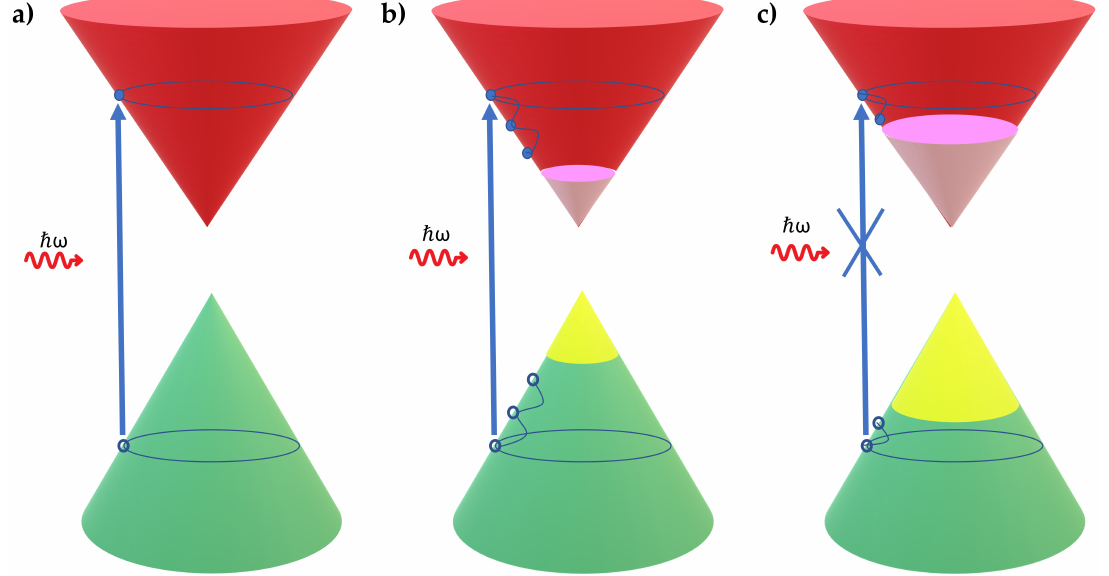
Figure 4. Absorption of photons in silicane: ( a ) schematic excitation process, where the arrow corresponds to an interband transition; ( b ) the photoexcited carriers thermalize and cool down to form a Fermi-Dirac distribution; ( c ) under high incident laser intensity, the photoexcited carriers occupy all the available states near the edge of the conduction and valence bands, thereby blocking any further